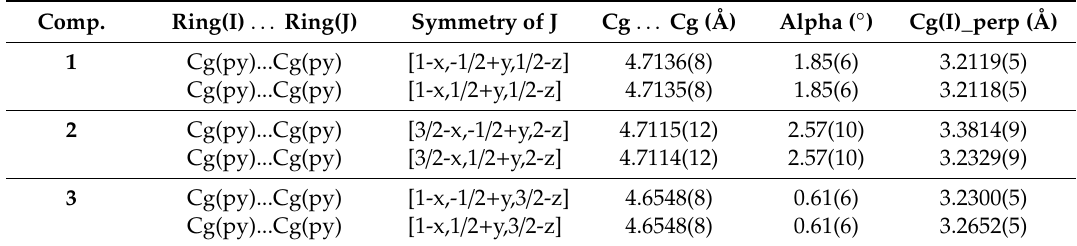
Table 1. Non-covalent π – π ring–ring interactions in 1 –